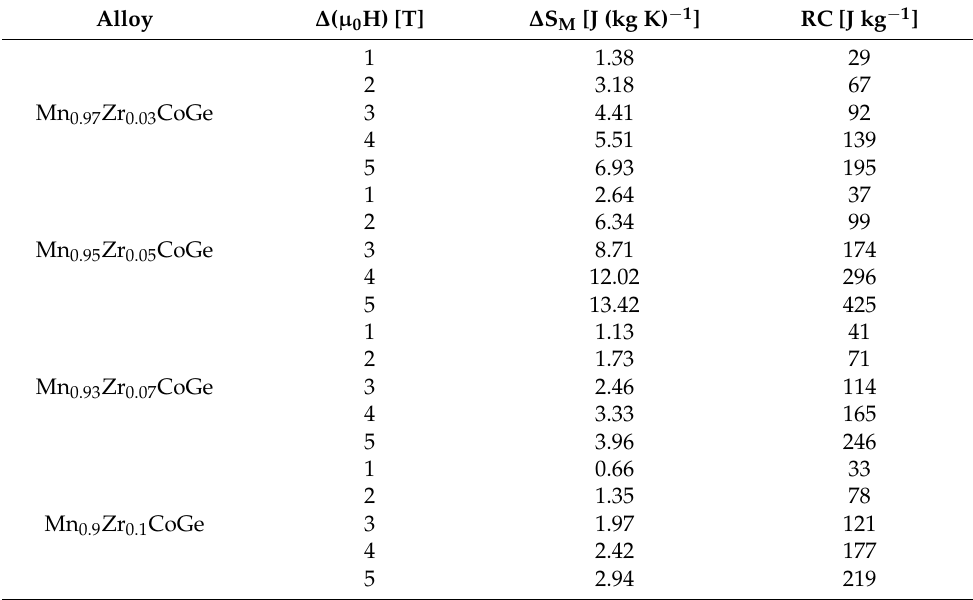
Table 2. The magnetic entropy change Δ S M and refrigerant capacity RC for the Mn 0.97 Zr 0.03 CoGe,